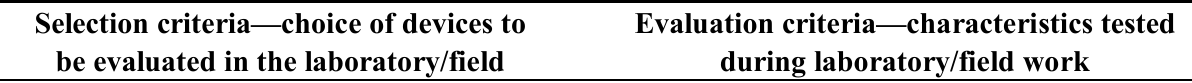
Table 1. Selection criteria for choice of HWTS and criteria for